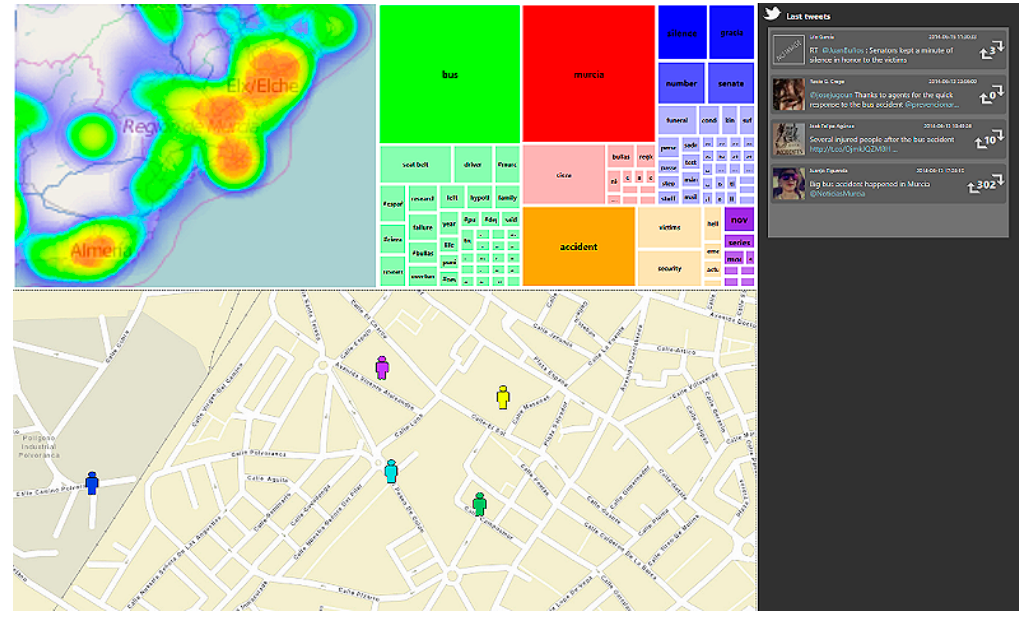
Figure 3. Displaying available citizen roles in map ‐ based interfaces. The colored icons in the map represent different types of citizens. The operator can interact with them by selecting the icons.